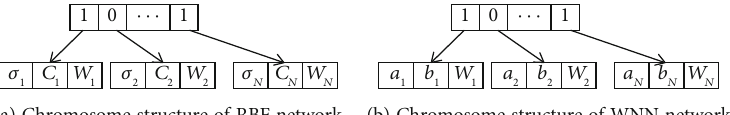
Figure 3: Chromosome structure of hierarchical genetic algorithm.